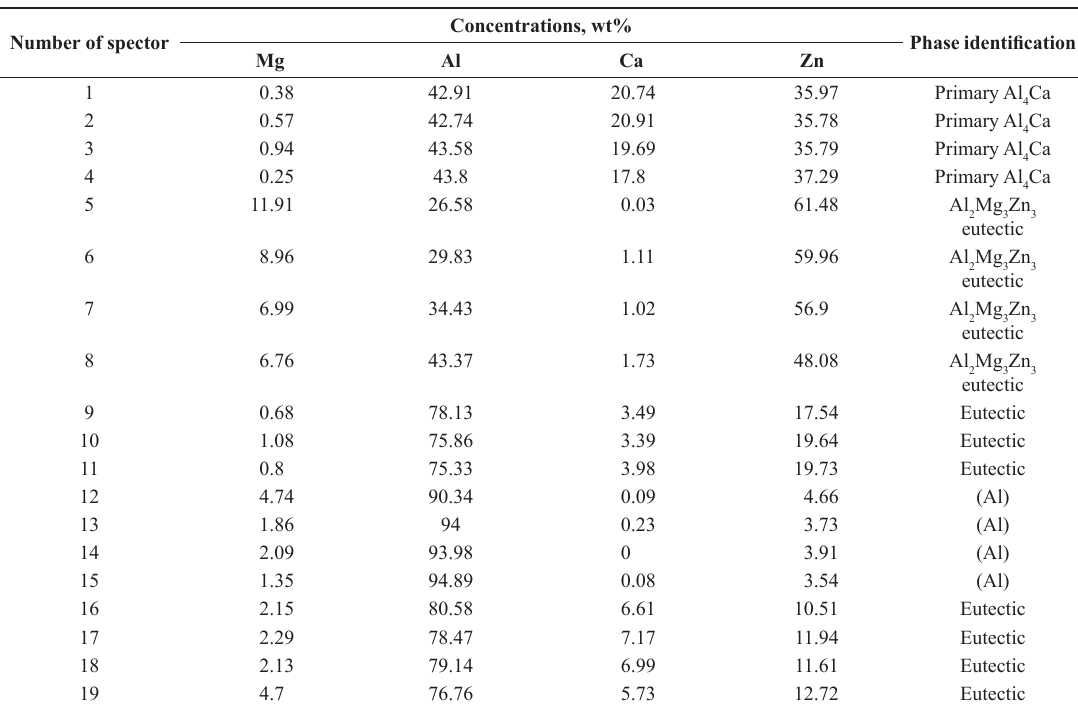
Table 2. The results of EMPA (see Figure